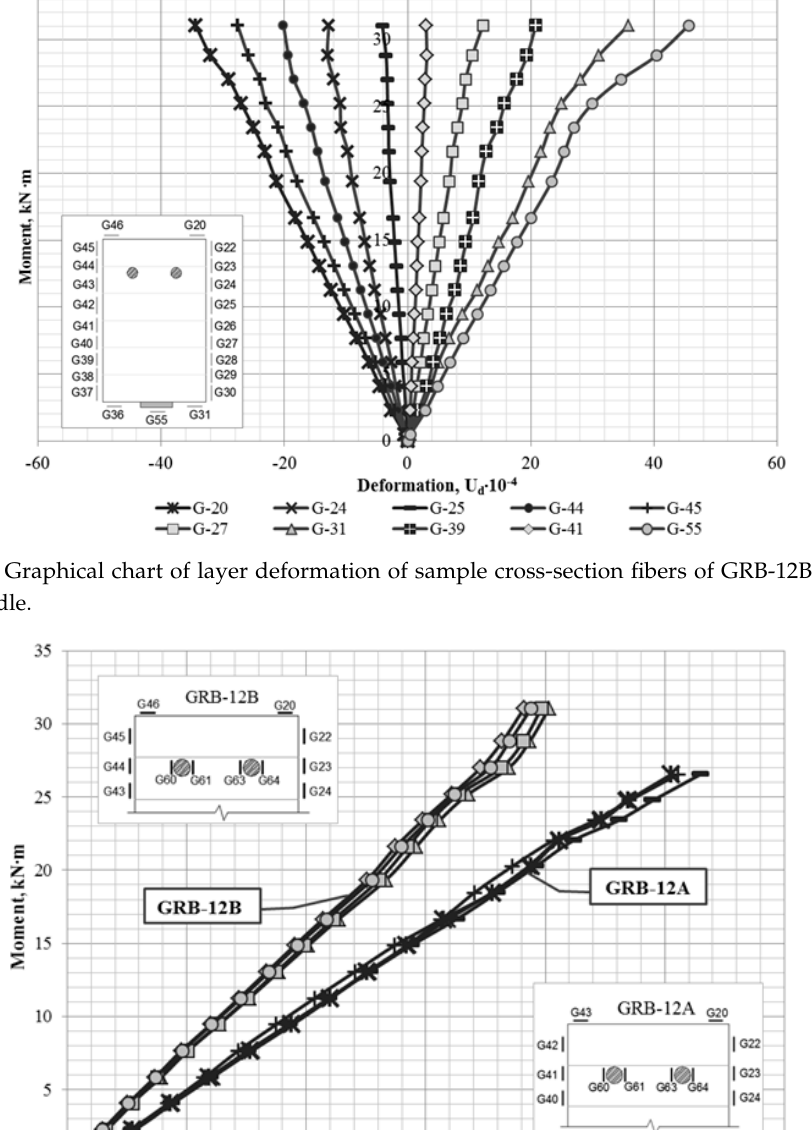
Figure 7. G raphical charts of deformations of most stressed fibers of wood in GB-A, GB-B, GRB-12A, and GRB-12B beams.